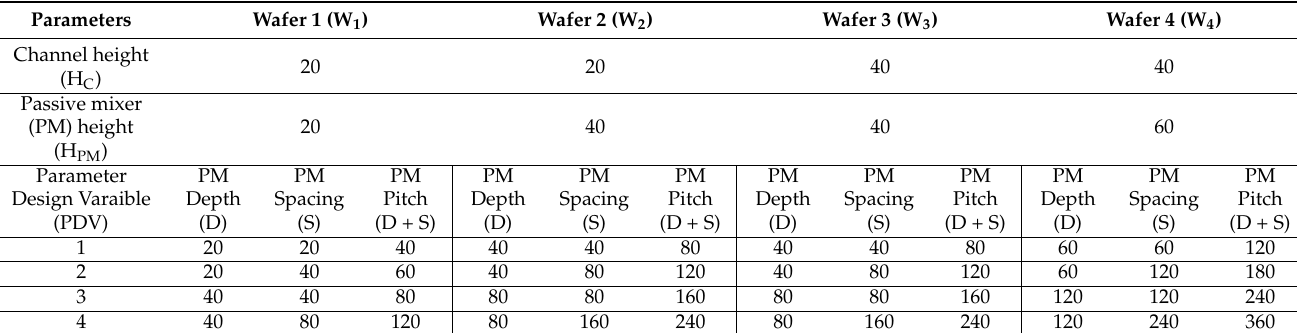
Table 1. Parameter values of microfluidic channels with DCMS in the ceiling of the microfluidic channel. The table lists all combinations of the parameters implemented by the lithography process. The design parameters are schematically illustrated in Figure 1. The master molds on the four wafers were realized for fabrication of channels with total heights: Wafer 1 (W 1 ) = 40 µ m, Wafer 2 (W 2 ) = 60 µ m, Wafer 3 (W 3 ) = 80 µ m and Wafer 4 (W 4 ) = 100 µ m. Sixteen different channels with design parameter variables were fabricated. All channels had a width (along the y-direction) of 100 µ m, and a mixing channel length (x-direction) of 1